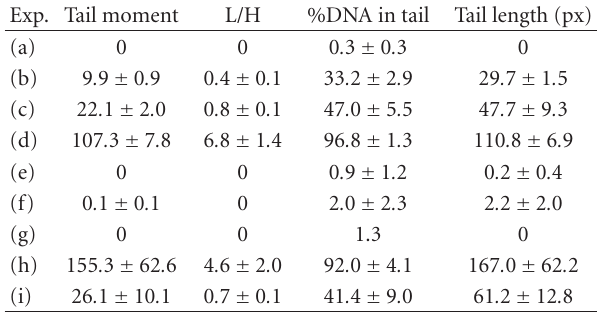
Table 1: Qualified data from SCGE